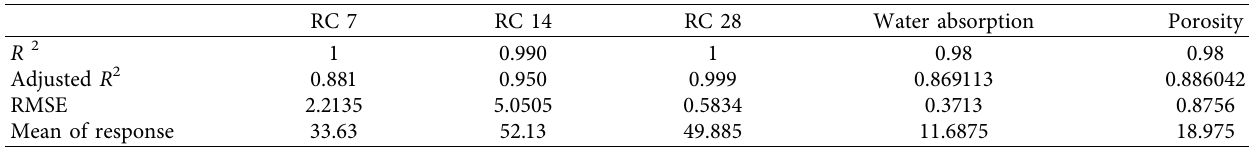
Figure 4: Porosity and water absorption of mortar at the age of 28 days. Table 2: Summary of